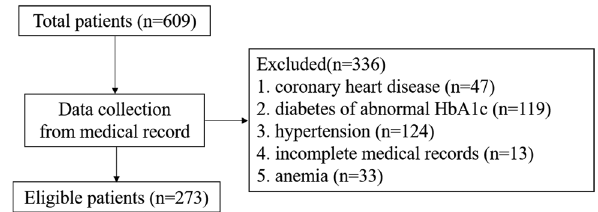
Figure 1: Details on the selection of